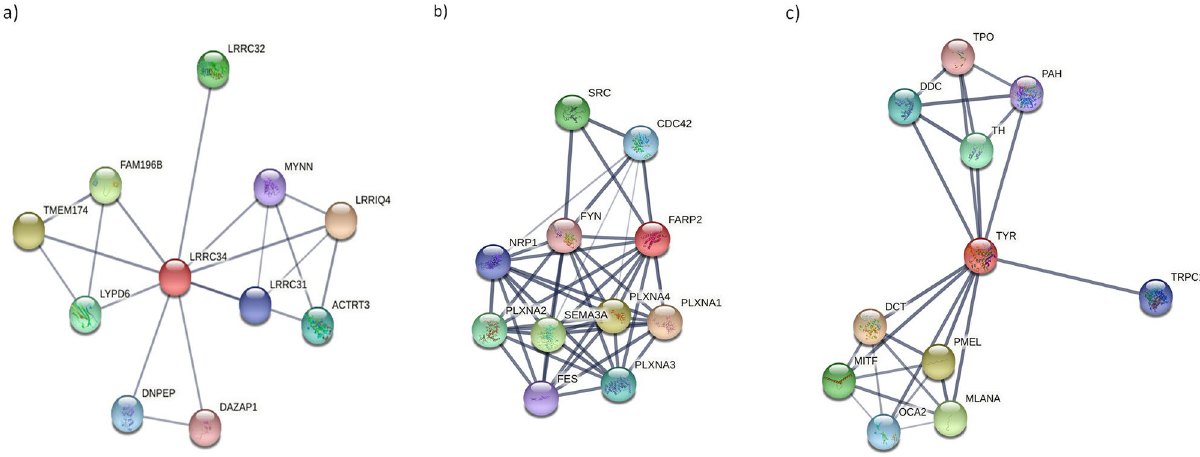
Figure 4. Protein–protein interaction network of proteins; ( a ) LRRC34, ( b ) FARP2, and ( c ) TYR using STRING server. The red node represents the studied proteins.